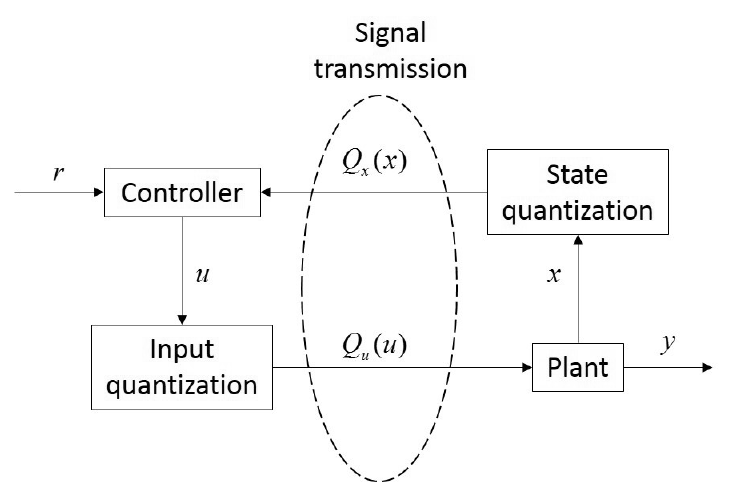
Figure 1. The signal transmission in networked control